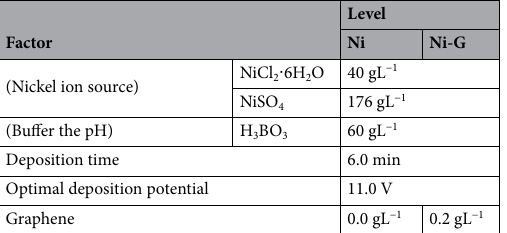
Table 1. Bath compositions and operating conditions for electrodeposition of Ni and Ni-graphene coating on the steel